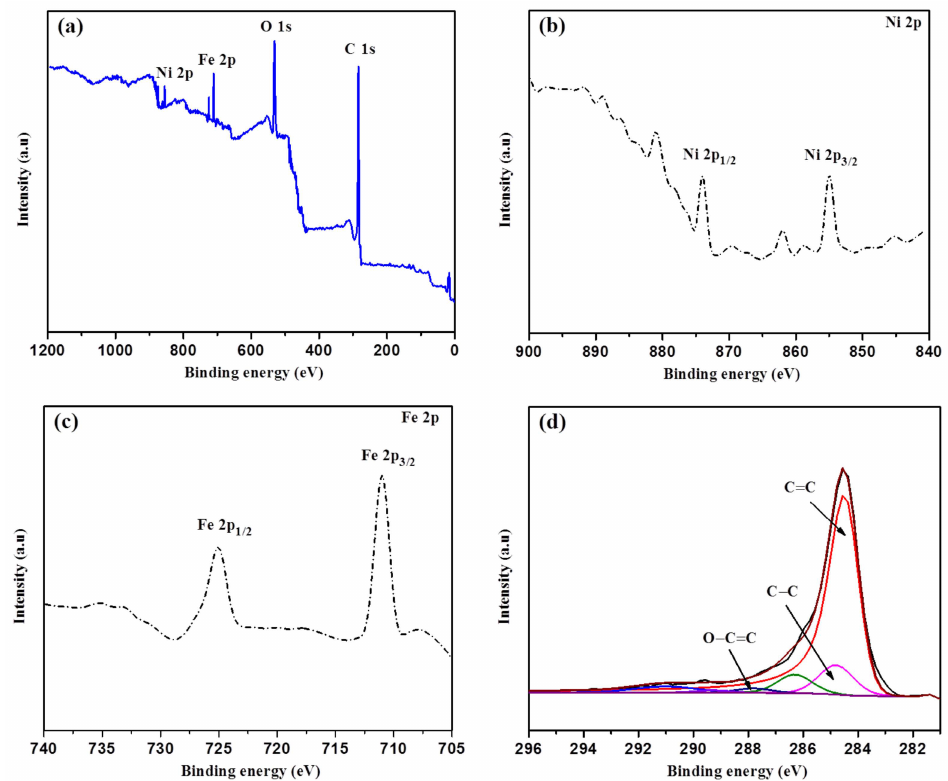
Figure 4. XPS analysis of the S5% Fe-Ni sample: ( a ) Survey scan; ( b ) Ni 2p spectra; ( c ) Fe 2p spectra; and ( d ) Deconvoluted XPS spectra of the C 1s